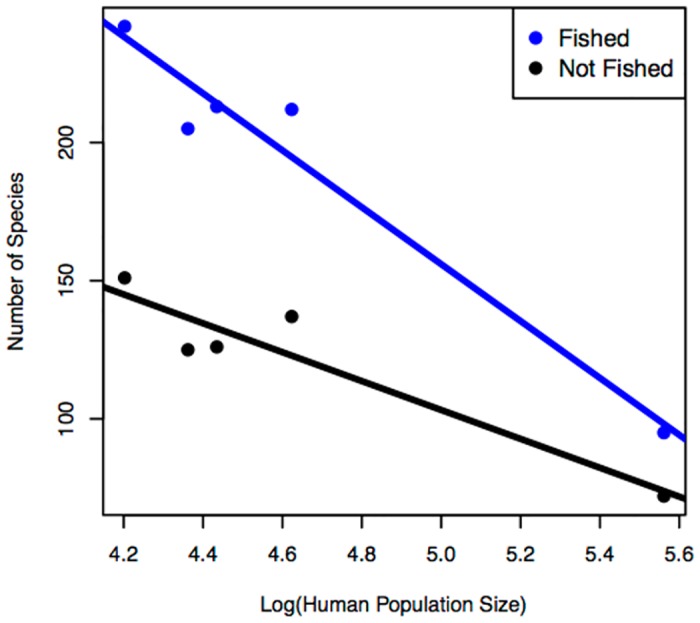
Regression analyses of human population size and the number of either fished or not-fished species.Human population has been log transformed.